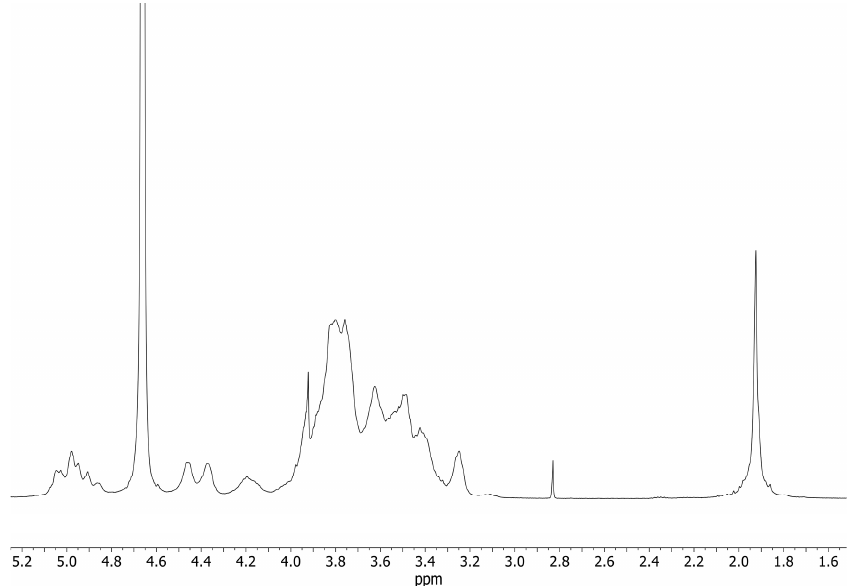
Figure 2. 1 H NMR spectra of HAL β CyD (D 2 O, 500 MHz).